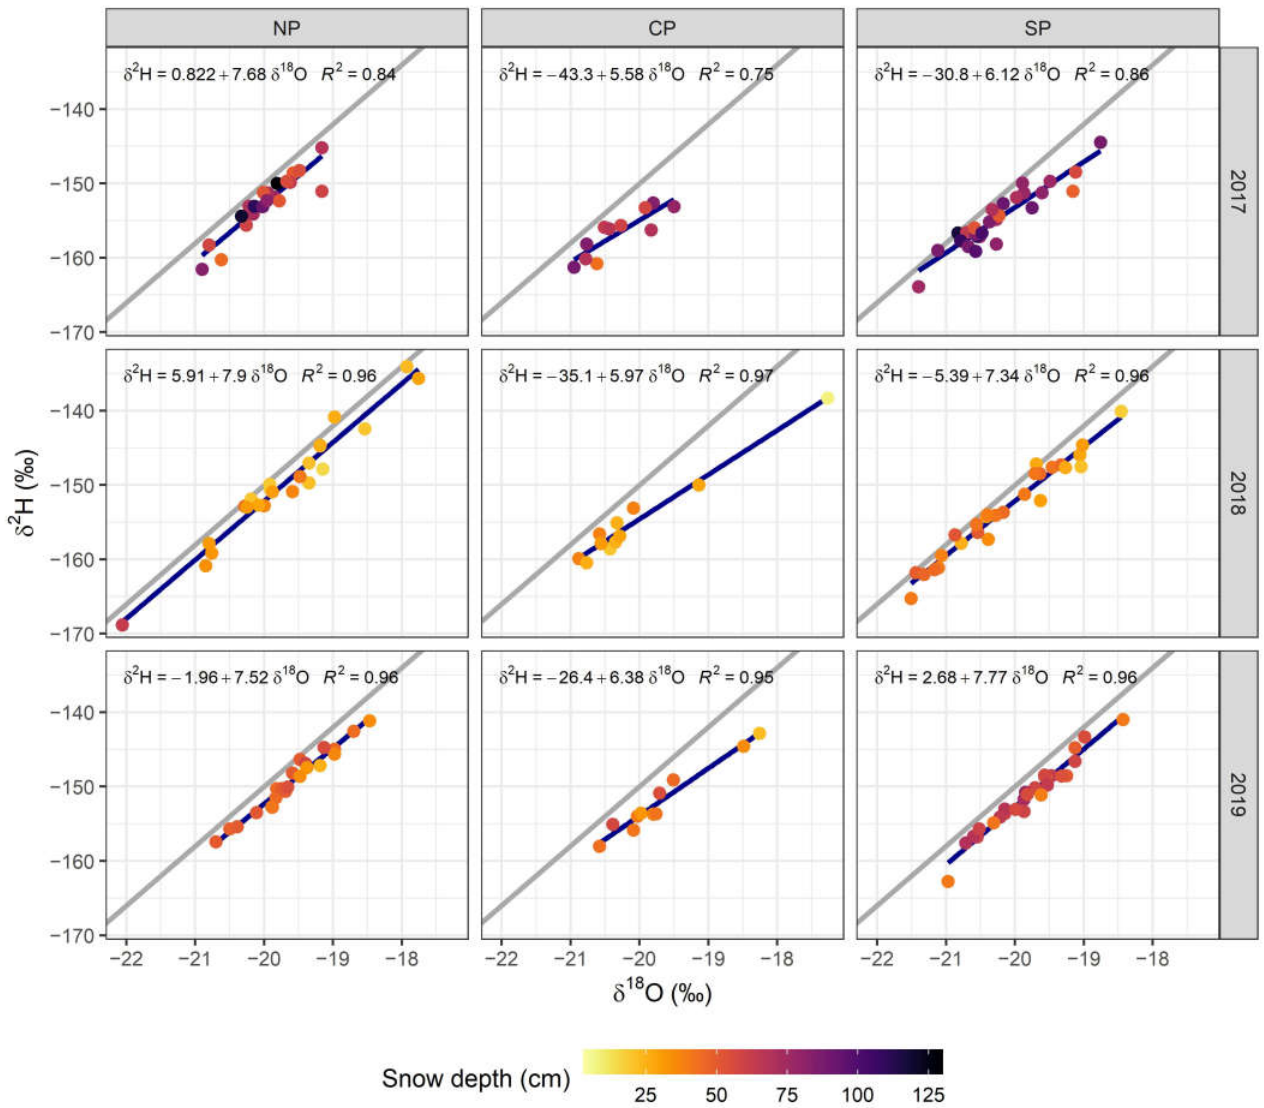
Figure 4. δ 2 H vs. δ 18 O plot over the basin parts (NP, CP, SP) and sampling years, including their regression lines (blue), global meteoric water line (gray), and snow depth gradient. Slope and intercept values of δ 2 H vs. δ 18 O regressions showed clear spatial patterns.